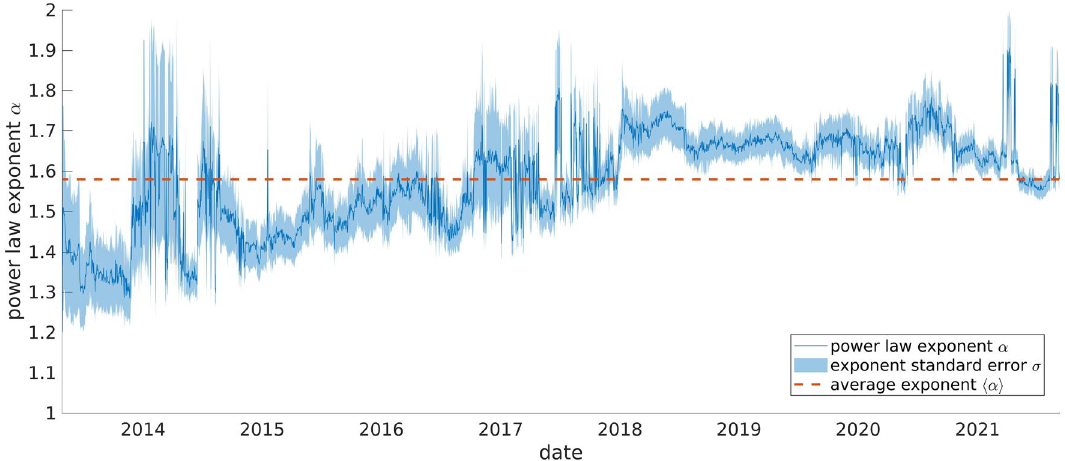
Figure 6. Power law exponent. Exponent of the power law distribution of market caps as function of time (blue line) and of its standard error (shaded area), both computed with a maximum likelihood approach. As the time elapses the error decreases since the number of coins over which the fit is performed increases. The red dashed line shows the average exponent obtained as an average weighted by the standard error. Figure created with Matlab R2021a https:// it. mathw orks. com/ produ cts/ matlab.